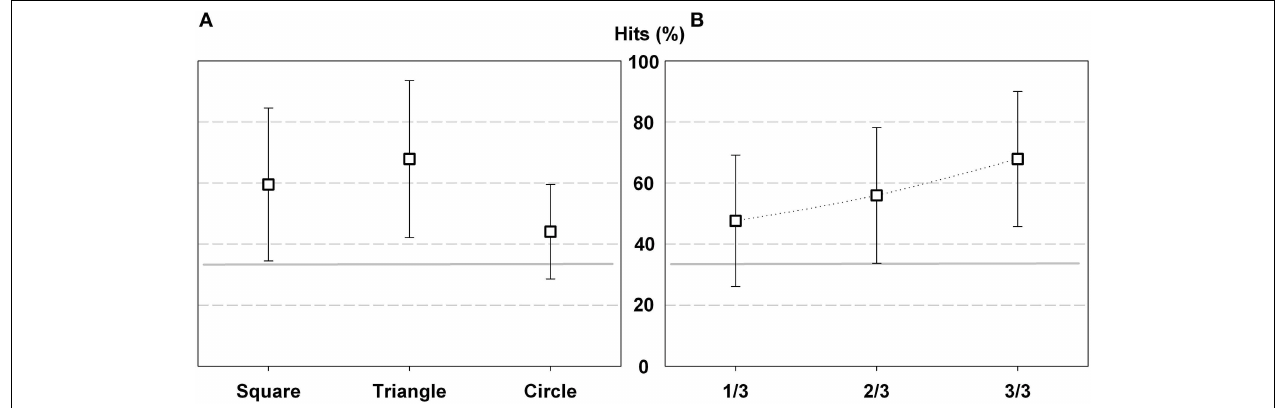
FIGURE 7 | Percentage of hits in Experiment 3 according geometric shape (A) and trial order (B). The gray horizontal line indicates the chance level (33%), and the error bars represent SD.